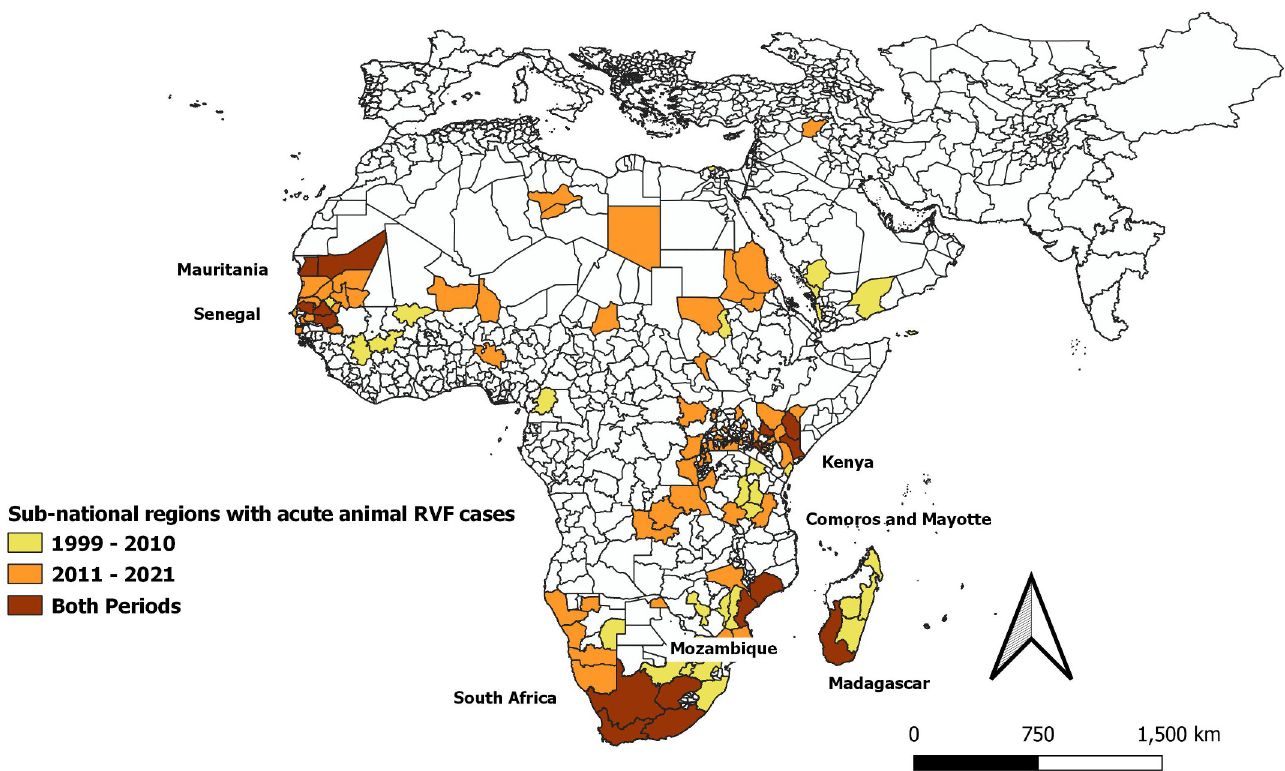
Fig 4. Sub-national administrative regions experiencing acute animal cases of RVF during the years 1999–2021. Locations are shaded according to whether they experienced outbreaks before or after 2011, or during both periods of time. Base map is from Database of Global Administrative Areas (GADM) (version 3.4, (April 2018,